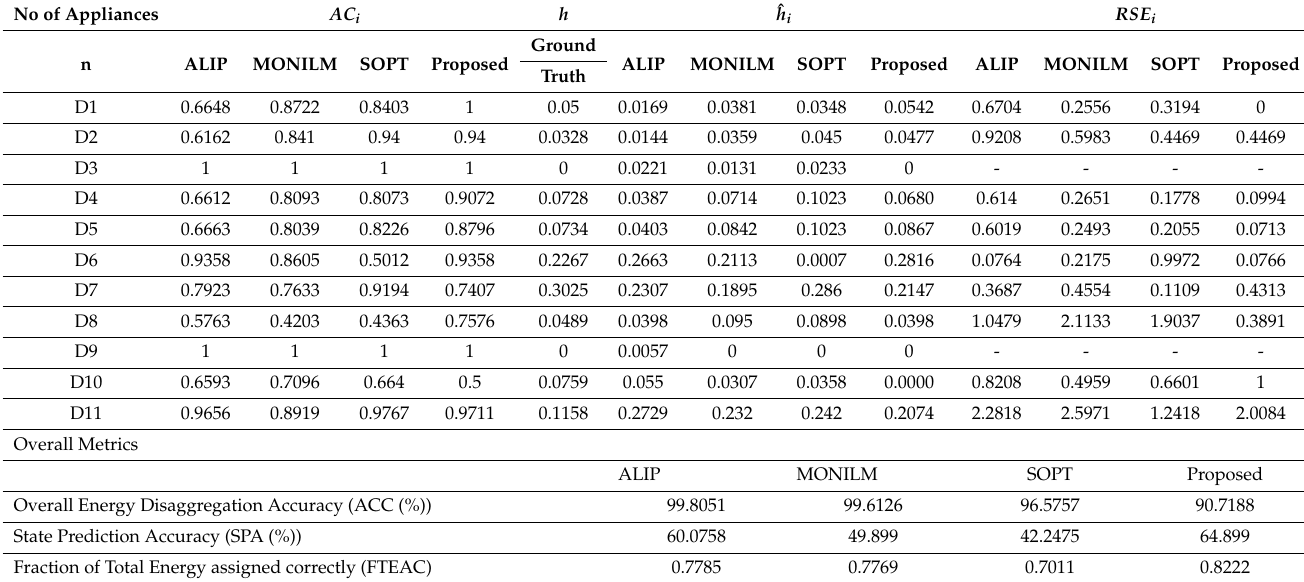
Table 5. Comparison of the proposed framework with the state-of-the-art methods in terms of energy disaggregation on the I 1 problem instance.